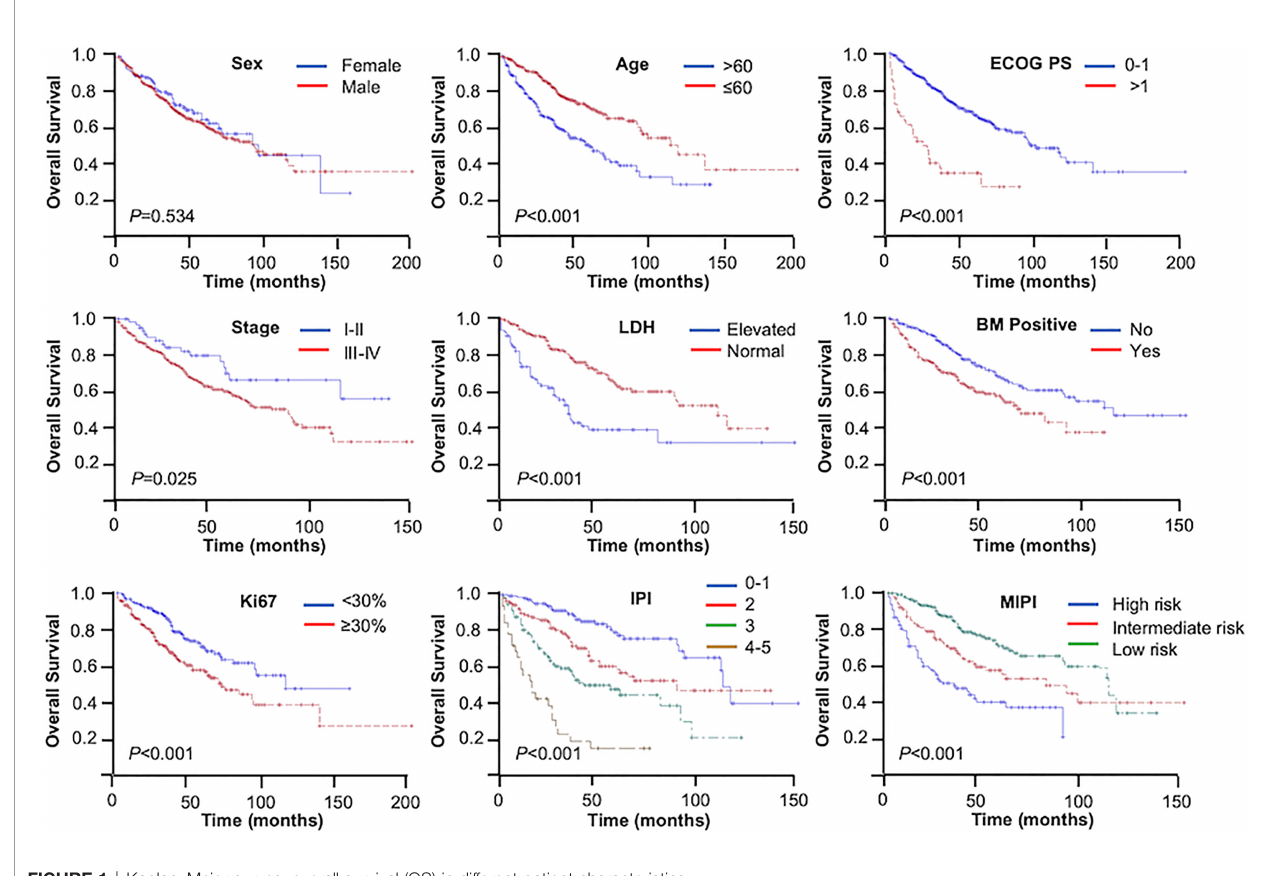
FIGURE 1 | Kaplan – Meier curves: overall survival (OS) in different patient characteristics.